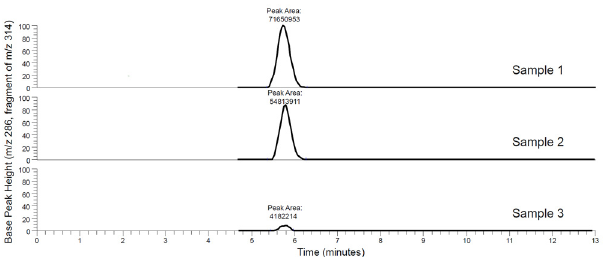
Fig 3. Representative selected chromatograms of filtered, spent broth showing a peak for the ethidium ion (MS-MS transition of m/z 314 to 286). Sample 1 is the negative control ( S . aureus cultured for 30 min in Mueller Hinton broth with 1.25 μ g/mL ethidium bromide and 10% DMSO), samples 2 and 3 were cultured under the same conditions as sample 1 with the addition of 75 μ g/mL and 300 μ g/mL piperine, respectively. All three peaks are normalized to a signal intensity of 3.45 x 10 6 . As piperine is added, efflux pumps are blocked, trapping the ethidium inside the cells and decreasing the quantity of ethidium (as indicated by the area of the ethidium peak) in the spent